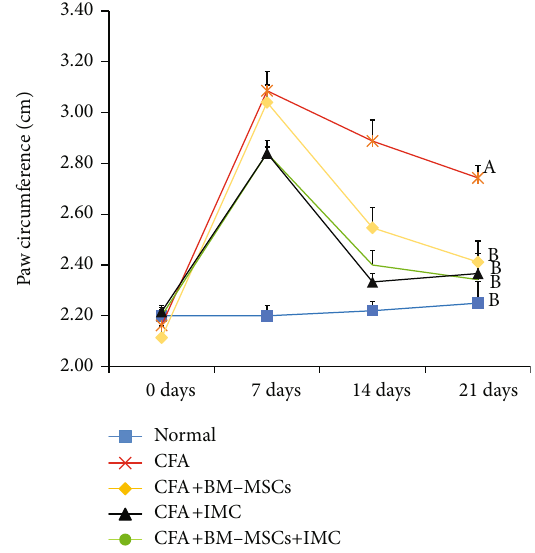
Figure 2: E ff ect of BM-MSCs and/or IMC on the right hind paw circumference (cm) in CFA-induced rats. Means, which have di ff erent symbols, A and B, are signi fi cantly di ff erent at p < 0 : 05 .